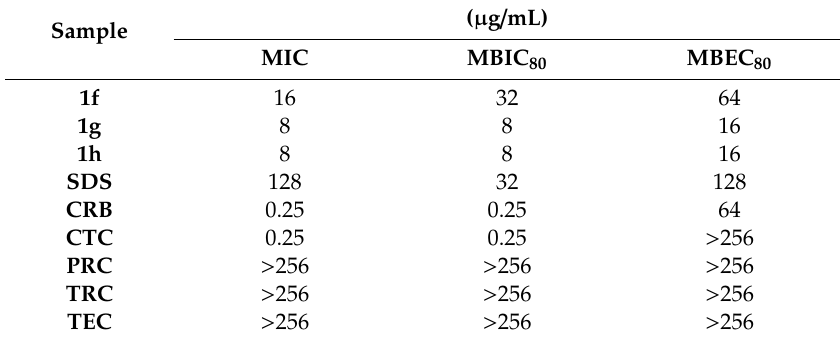
Table 7. Comparison of minimum inhibitory concentrations (MICs), minimum biofilm inhibitory concentrations (MBIC 80 ), and minimum biofilm eradication concentrations (MBEC 80 ) ( µ g / mL) of tested compounds and